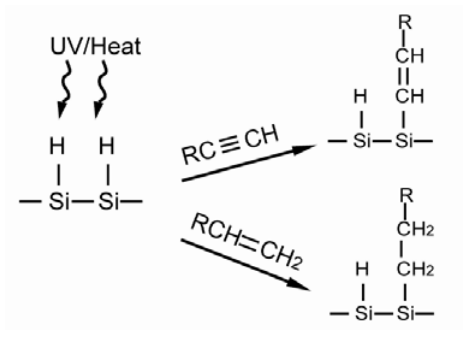
Figure 9. Alkyl chains of 1-alkyne and 1-alkene terminals are connected to the S-H radicals on the silicone surface (adapted from [82]).